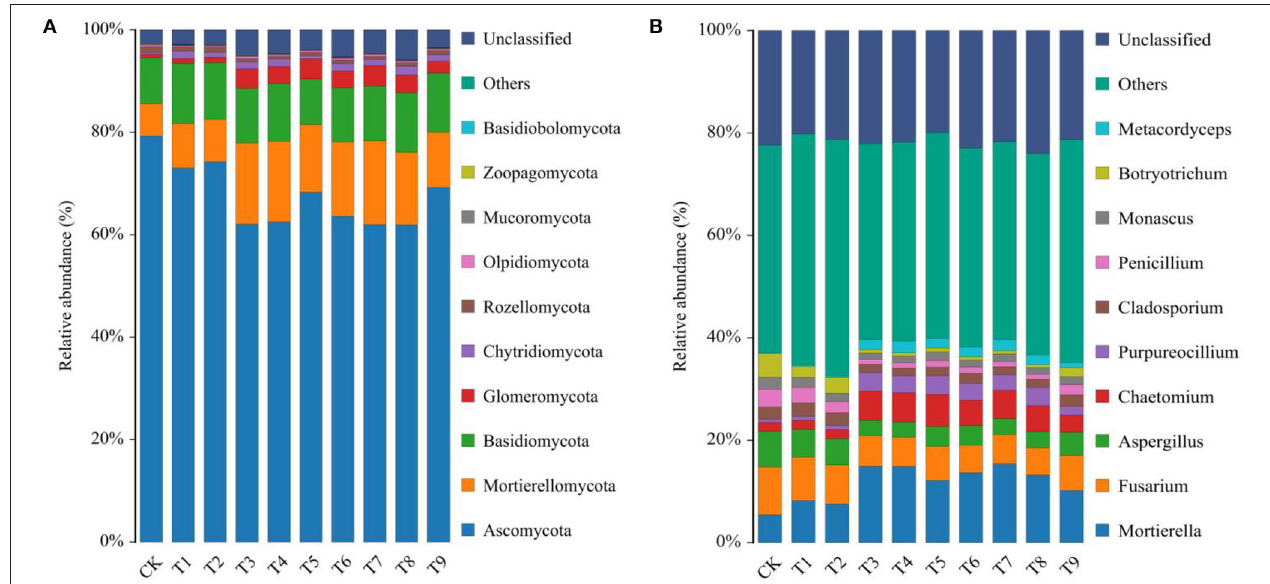
FIGURE 4 | Relative abundance of fungal, (A) phyla, and (B) genera in rhizosphere soils of ginseng in 10 fertilization treatments. Note: (a) Composition of fertilization treatments: CK,